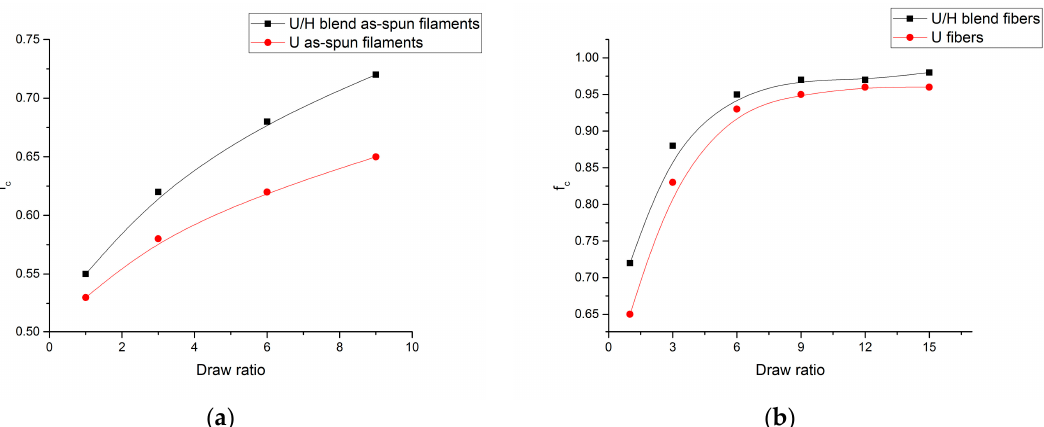
Figure 13. Crystal orientation of as-spun filament and fiber samples: ( a ) as-spun filament samples; and ( b ) fiber samples.